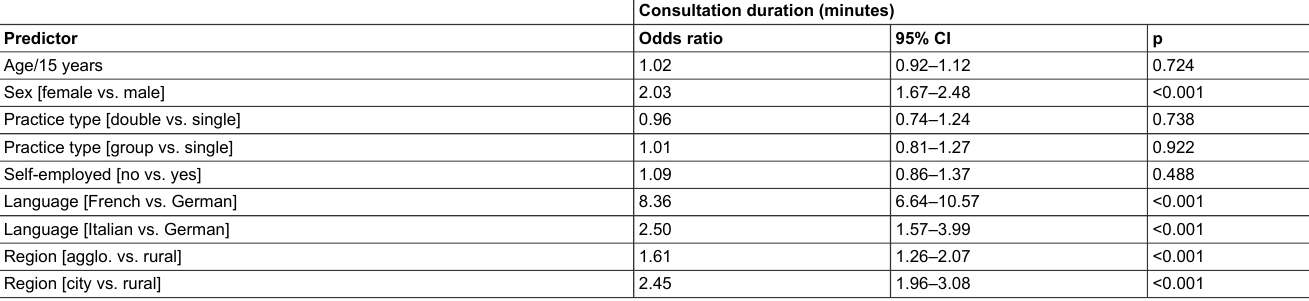
Table 3: Multivariable ordinal logistic regression analysis to test the association of age, sex, practice type, employment, language and region with the categorised variable consultation duration in 2020 (<15 min, 15 min, 20 min, 30 min, >30 min).